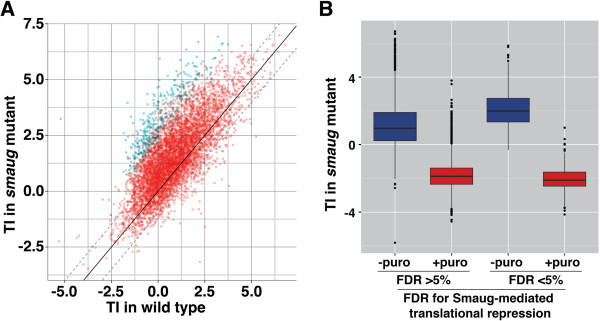
Identification of the targets of Smaug-mediated translational repression. (A) The averages, across three biological replicates, of the TI in smaug-mutant and wild-type embryos were plotted against one another. SAM analysis allowed for the identification of 359 transcripts (blue dots) representing 342 genes that show an increase in TI in smaug mutant versus wild type at an FDR of <5%, while the red dots represent genes with FDRs of >5%. The solid diagonal line represents no enrichment and the dotted diagonal lines represent two-fold enrichment or depletion. (B) Polysome gradients from smaug-mutant embryos were performed with or without puromycin treatment and the average, across two biological replicates, of the TI for each gene was calculated. Box plots show the range of TIs for genes where the TI increased in smaug-mutant embryos versus wild type with an FDR <5% and those with an FDR >5%, as defined in (A).